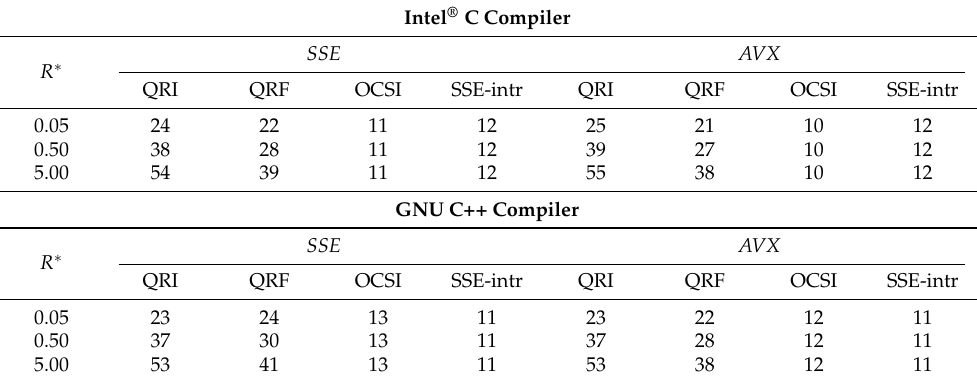
Table 1. Average run-times of the C/C++ version of algorithms for collision detection between one L ∗ W ∗ cuboid of 1 20 and 1 20 and one sphere of radius R ∗ over 2 ≤ ≤ ≤ ≤ with 40% of acceptance ratio. Results, reported in ms, are obtained compiling the benchmark program using Intel ® C Compiler and GNU C++ Compiler, enabling the generation of SSE and AVX instructions. The standard deviations of all the run-times are <0.5 ms.